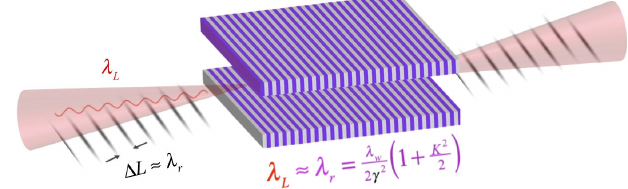
FIG. 2. Schematic layout of the modulator system. The system consists of an undulator, a microbunch train and the external seed laser. The external laser modulates the beam and provides longitudinal focusing to the individual microbunches. The un- dulator is designed to match the resonance condition with the external laser and the bunch spacing is set close to the undulator resonant